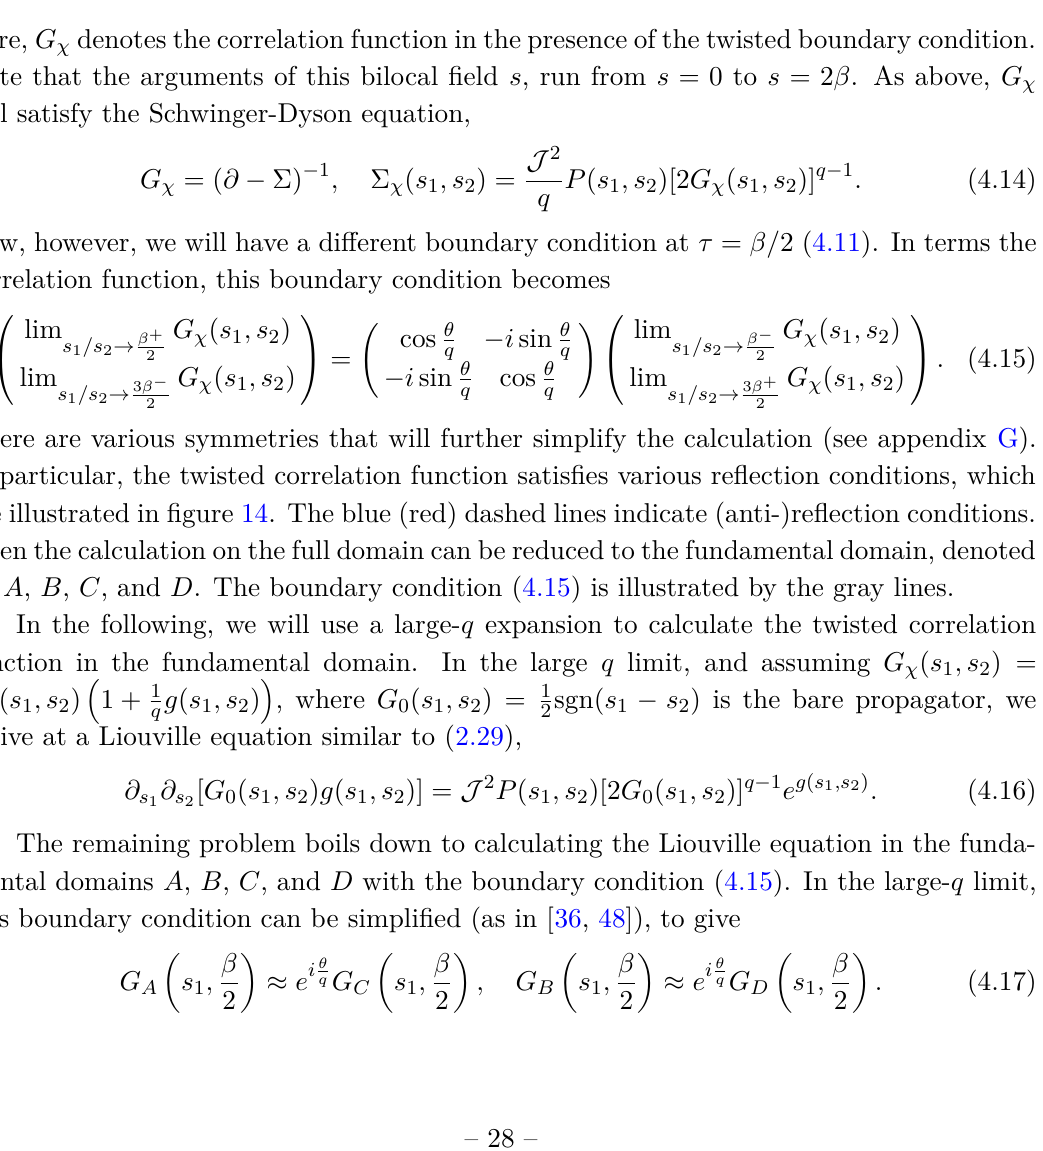
Figure 14. The full domain of twisted correlation function. The blue dashed lines indicate the reflection boundary condition, and the red dashed line indicates the anti-reflection boundary condition. With the help of these boundary conditions, we can reduce the calculation to the fundamental domains A , B , C and D . The gray solid lines indicate the boundary condition at s 1 , 2 = β/ 2 , 3 β/ 2